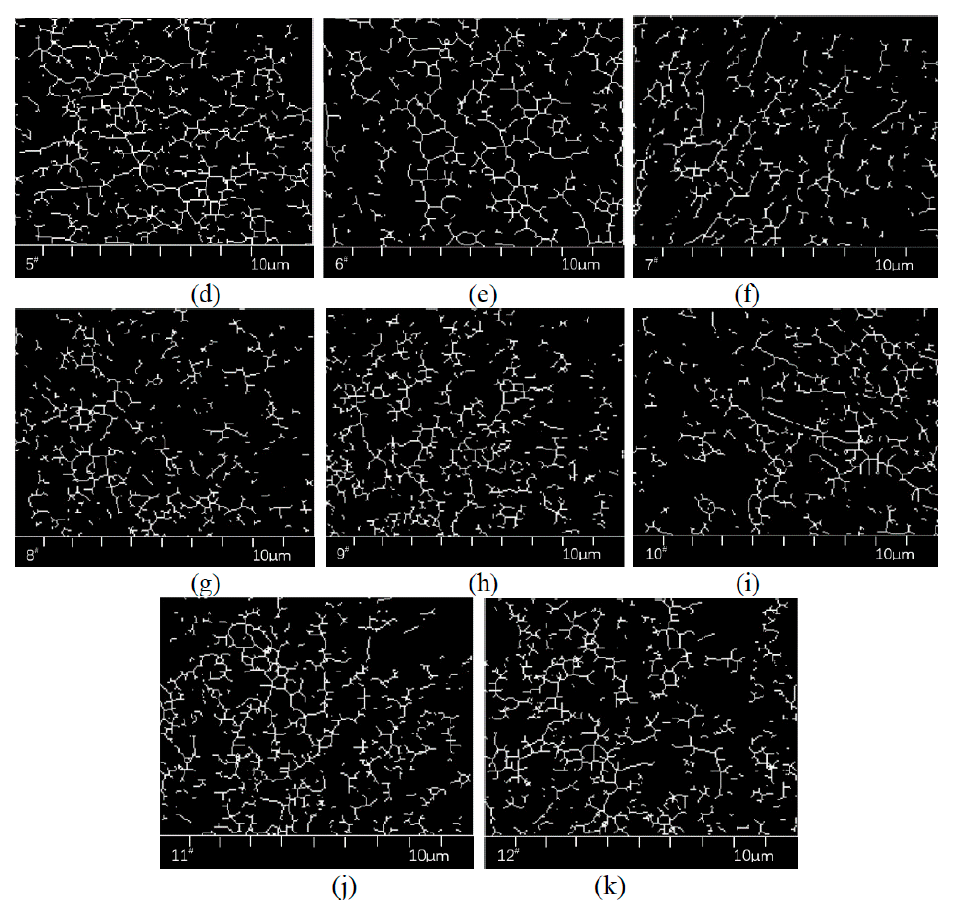
Figure 7. The representative skeletonized image of direct-to-plant SBS modified bitumen modifier: ( a ) 2 # , ( b ) 3 # , ( c ) 4 # , ( d ) 5 # , ( e ) 6 # , ( f ) 7 # , ( j ) 8 # , ( h ) 9 # , ( i ) 10 # , ( j ) 11 # and ( k ) 12 # .